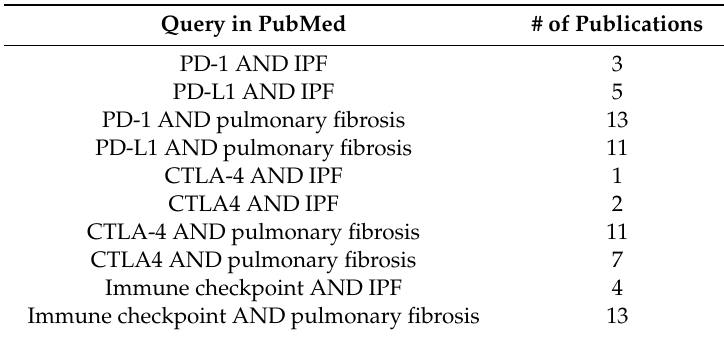
Table 1. Search terms used to select relevant papers focusing on immune checkpoint inhibition in idiopathic pulmonary fibrosis